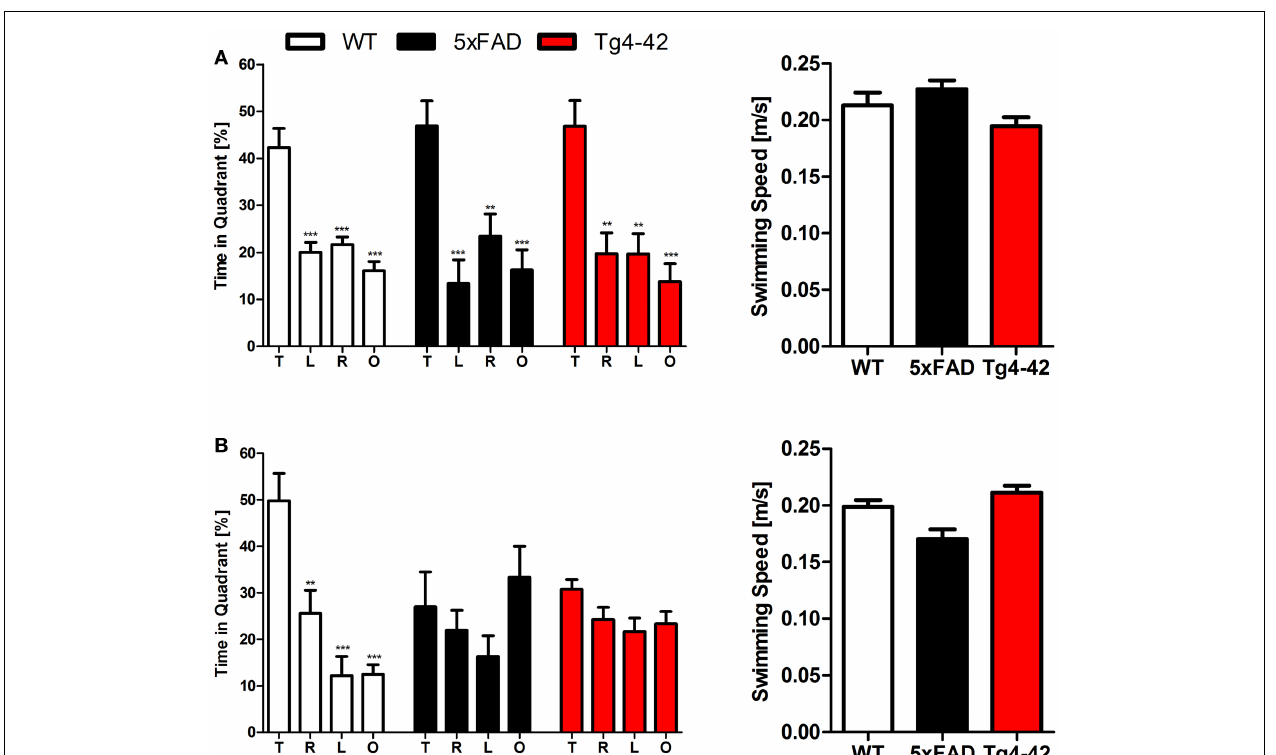
vs. L and O, p < 0.01T vs. R;Tg4–42: p < 0.001T vs. O, p < 0.01T vs. R and L).The swimming speed did not differ between the groups. (B) Probe trial revealed a significant reduced learning behavior for agedTg4–42 and 5XFAD mice as they showed no preference for the target quadrant.WT mice have no learning deficits at this age (WT: p < 0.001T vs. L and O, p < 0.01T vs. R). Swimming speed did not differ between the groups.T, target quadrant; L, left quadrant; R, right quadrant; O, opposite quadrant. Quadrant preference and swimming speed; One-way analysis of variance (ANOVA) followed by Bonferroni multiple comparisons. *** p < 0.001; ** p <